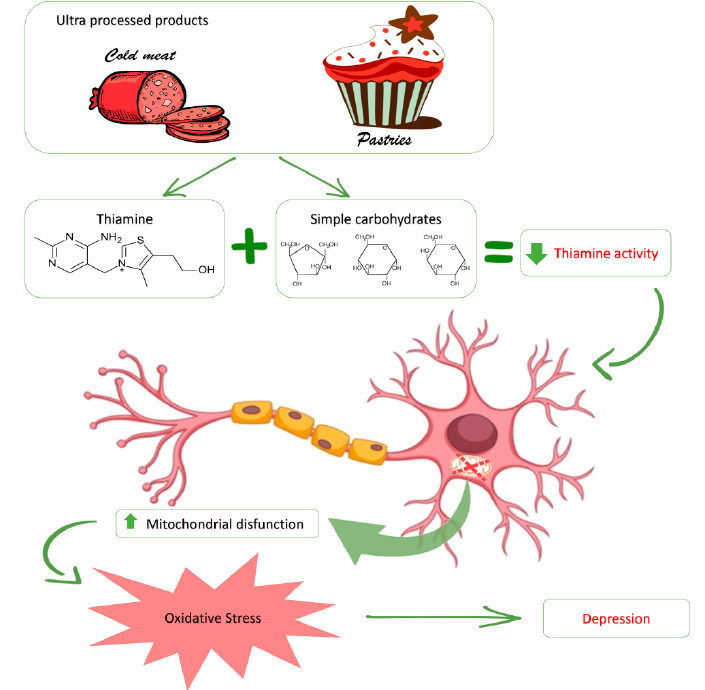
Figure 3. Activity of vitamin B1 (thiamine) and its role in the presence of depression in MS